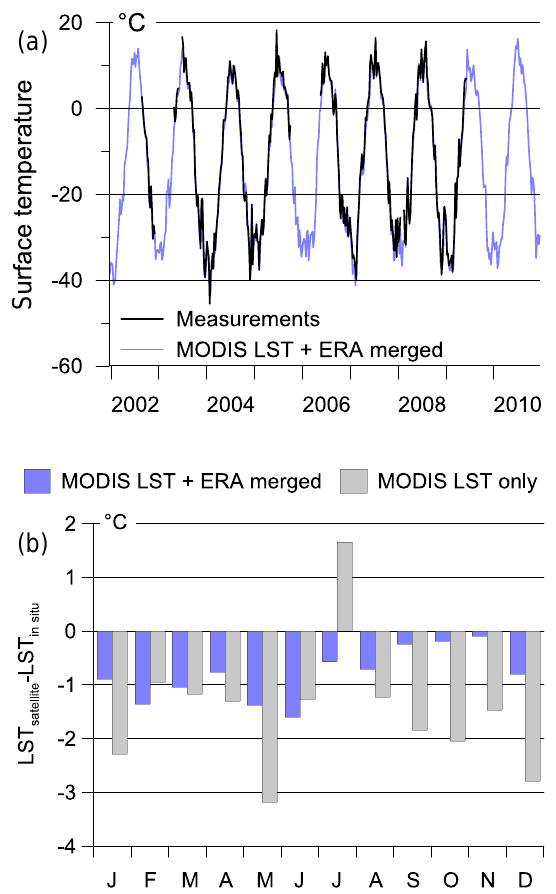
Figure 2. (a) Daily average surface temperatures measured on Samoylov Island (Langer et al., 2013; Boike et al., 2013) vs. sur- face temperatures synthesized from MODIS LST and ERA-Interim reanalysis. (b) Difference between satellite-derived LST and in situ measurements for monthly averages of periods when in situ mea- surements are available (see a ). See text.